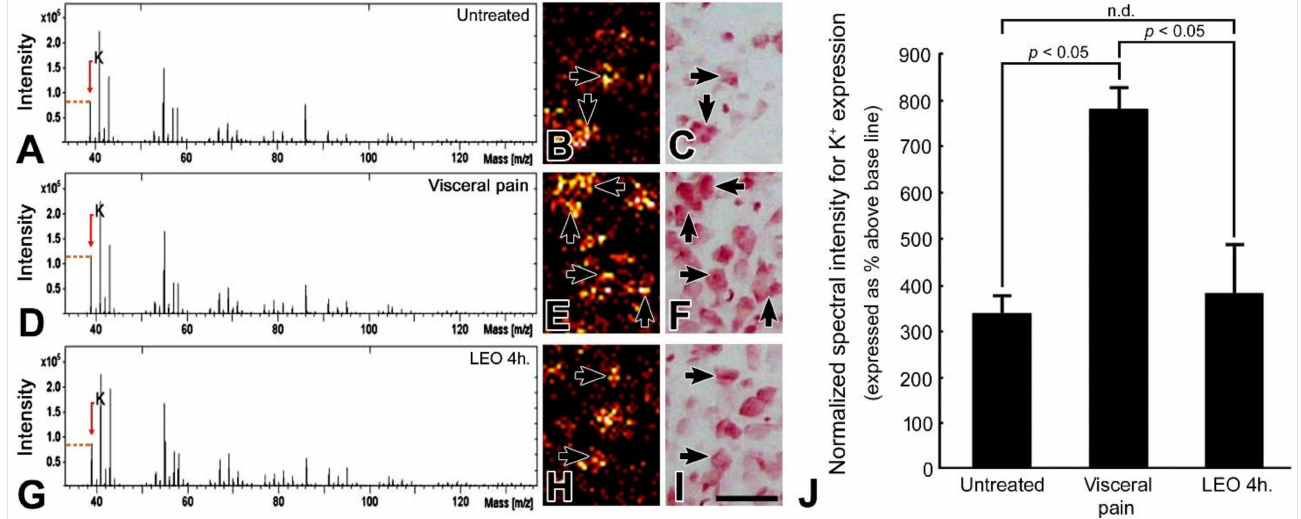
Figure 5. TOF-SIMS-positive spectra ( A , D , G ), ionic imaging ( B , E , H ), corresponding histological staining with H&E ( C , F , I ), and histogram ( J ) show the K + expression in the CeA of the untreated ( A – C ), visceral pain ( D – F ), and OS with LEO for 4 h ( G – I ) groups. Note that in untreated group, only moderate K + intensity ( A ) with significant intracellular localization (arrows, B ) was detected in the CeA. However, following the induction of visceral pain, the amygdaloid K + expression was drastically increased in both terms of spectral intensity ( D ) and ionic imaging ( E ). Nevertheless, in rats subjected to visceral pain and treated with LEO, the amygdaloid K + expression was successfully returned to nearly normal levels in which only a mild level of K + signal was detected in the CeA ( G , H ). Arrows in ( B , E , H ) indicates the intracellular localization of the K + signal as verified by the H&E staining in ( C , F , I ). Data from normalized spectral intensity analysis corresponded well with imaging findings in which OS effectively decreased the CeA K + intensity ( J ). n.d. = no significant difference. Scale bar = 50 µ m in ionic and histological